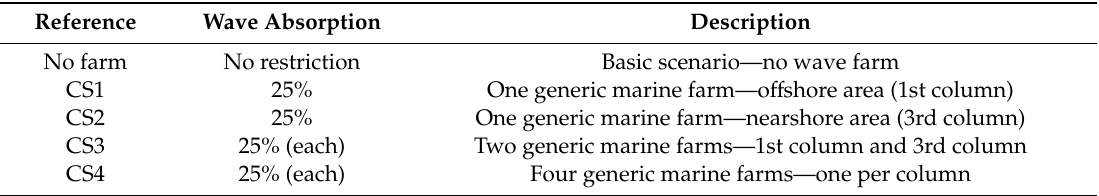
Figure 2. Computational domain of the target area (bathymetric map), including the wind farm configuration, the main scenarios (CS1, CS2, CS3 and CS4), the nearshore reference points (N1–N9), and the reference lines (L1–L9). and the reference lines (L1–L9). Table 1. Scenarios selected for the implementation in the wave modeling Table 1. Scenarios selected for the implementation in the wave modeling system.